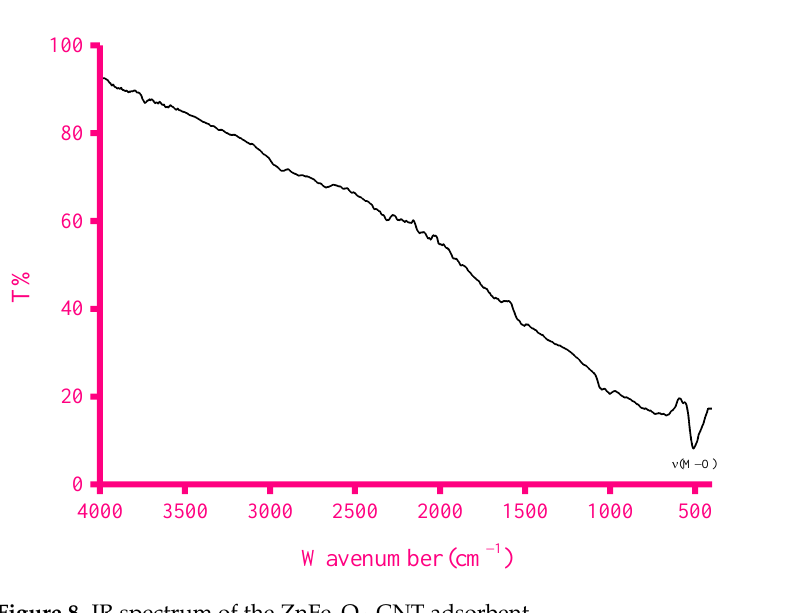
Figure 7. The magnetic properties of the ZnFe 2 O 4 -CNT adsorbent.